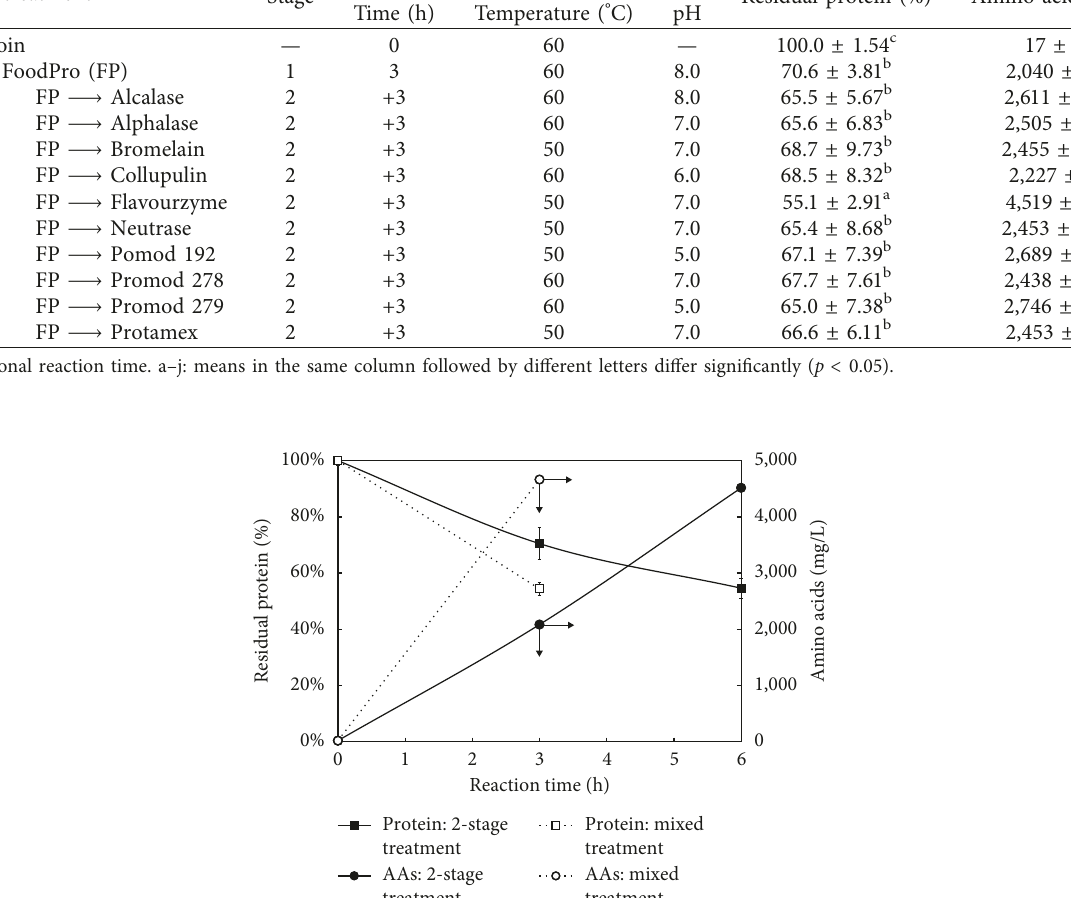
Table 4: Selection of the second proteolytic enzyme to enhance the efficiency of enzymatic hydrolysis of FoodPro-treated silk fibroin. Enzyme treatment